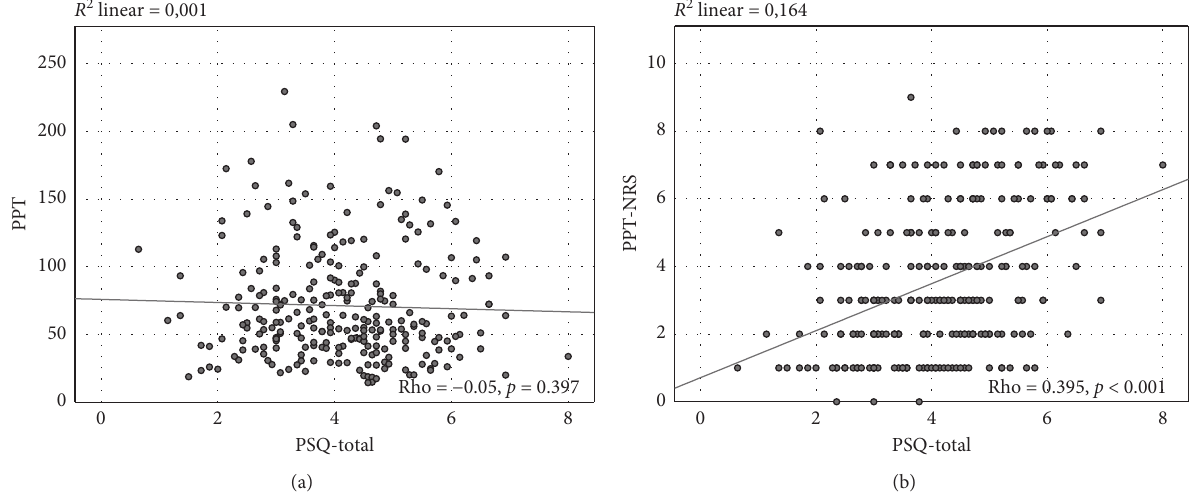
Figure 4: Illustration of the correlations between total score of the Pain Sensitivity Questionnaire (PSQ) and results of experimental pressure pain testing. (a) Correlation between the total score of PSQ (PSQ-total) and the pressure pain threshold (PTT). (b) Correlation between the total score of PSQ (PSQ-total) and the pressure pain threshold numerical rating scale (PTT-NRS). Linear regression lines are displayed, and Spearman’s correlation coefficients (rho) as well as p values are given ( n �